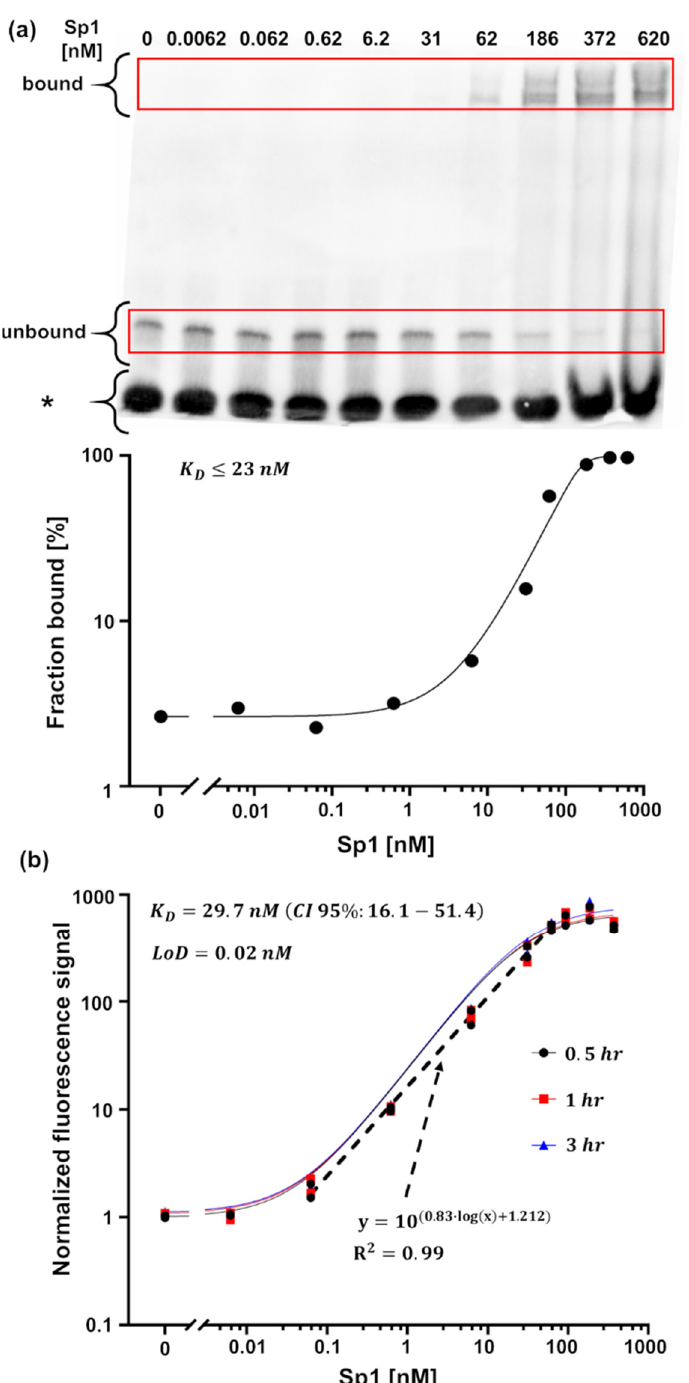
Figure 7 . Dose response behavior of recombinant human Sp1 interaction with DNA. ( a ) A representative EMSA blot. The graph below the blot is the fraction of DNA bound with increasing concentrations of Sp1, calculated as ( bound ) / ( bound + unbound ) . The band designated with an asterisk (“*”) represents the population of dsDNA that the protein is unable to bind. ( b ) Dose response at different incubation times (t) using the MMB system ( n = 2 ) . Reprinted (adapted) with permission from [38] Copyright (2022) by American Chemical Society.